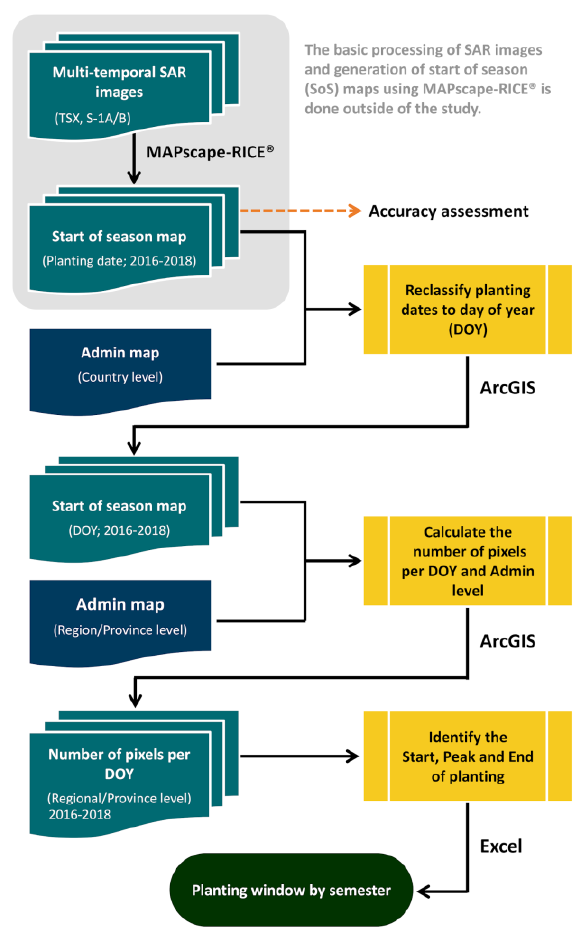
Figure 2. Planting window process flow used in this study.